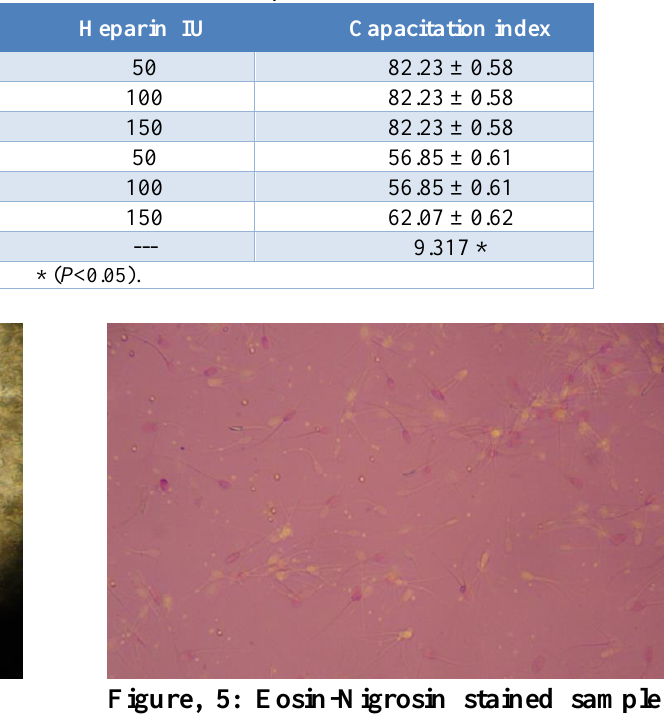
Table, 4: Effect of heparin level under season influences on capacitation index.